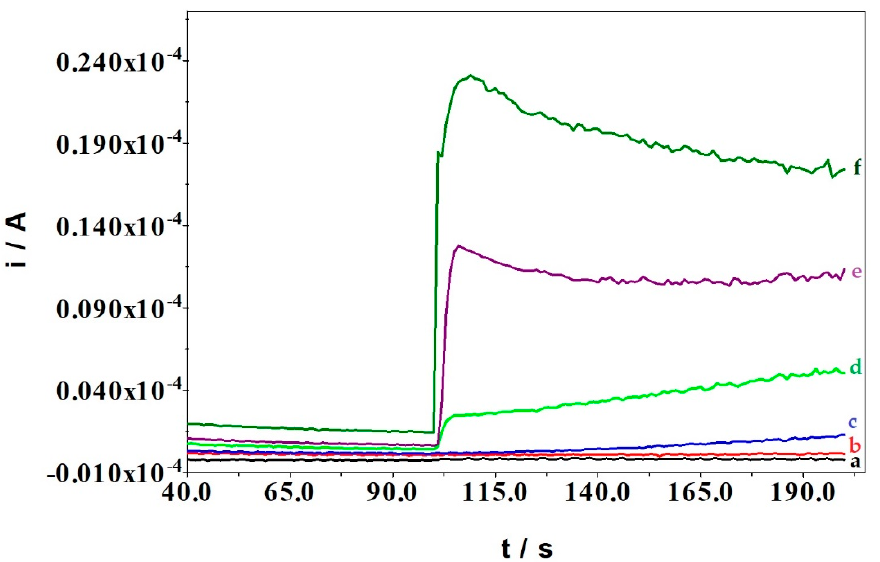
Figure 4. Amperometric response for 0.64 mM cholesterol added in the mixture (2 mL chloroform- TBAP + 1 mL acetic anhydride + 40 µ L H 2 SO 4 ) for different applied potentials: 0.8 V ( a ); 1.0 V ( b ); 1.2 V ( c ); 1.4 V ( d ); 1.5 V ( e ); 1.6 V ( f ).